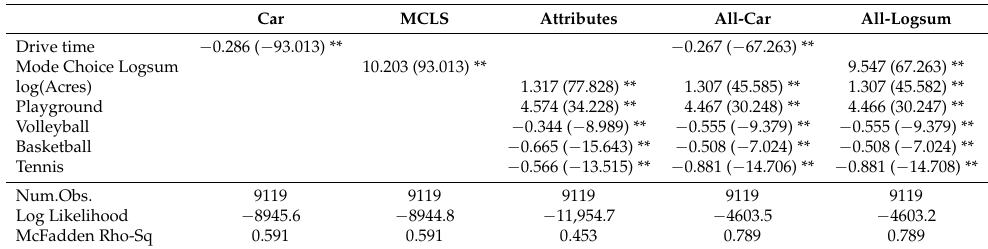
Table 2. Park Destination Choice